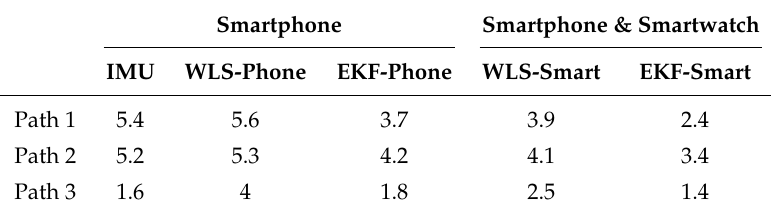
Table 1. Results of the experimental validation in terms of RMSE. WLS, weighted least squares.